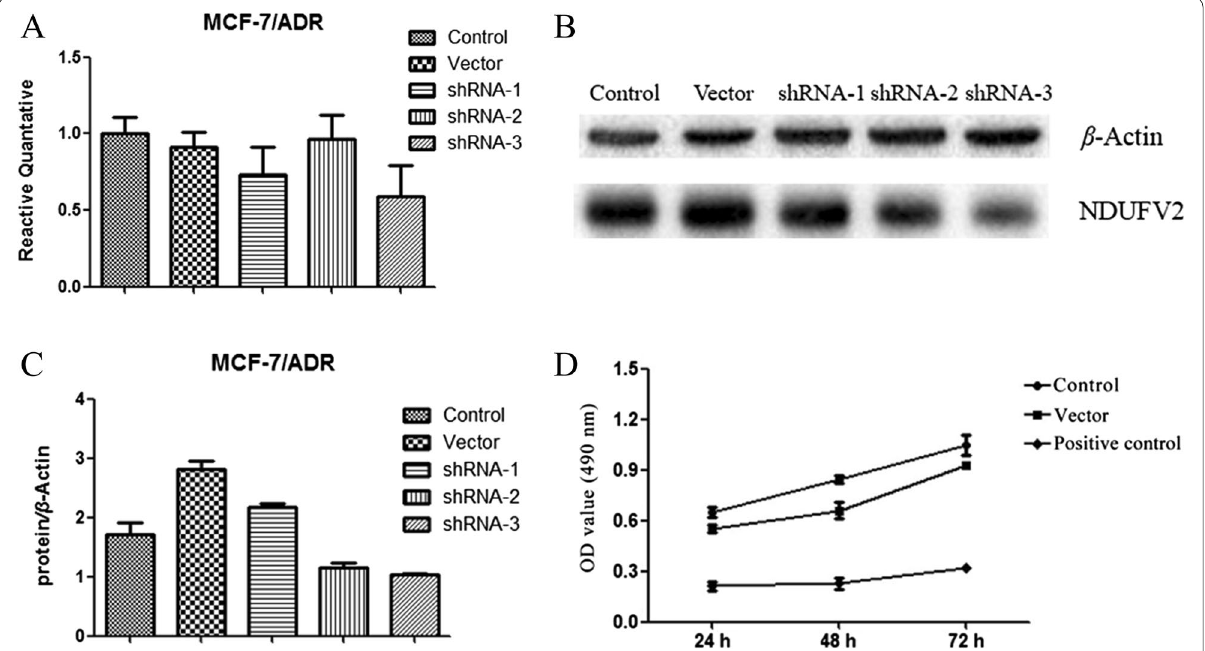
Fig. 2 Inhibition of NDUFV2 gene silencing on the proliferation of MCF-7/ADR cells. A The relative quantitative rates of NDUFV2 mRNAs in each group of MCF-7/ADR after transfection at different time points x ± s , n = 3 . B The protein expressions of NDUFV2 after transfection in MCF-7/ADR cells. β-actin was used as an internal reference protein, and NDUFV2 was used as the target protein. C The protein expressions of NDUFV2 in MCF-7/ ADR after transfection x ± s , n = 3 , β-actin was used as an internal reference protein and NDUFV2 was used as the target protein. For A , B , and C , cells transfected with PPLK /GFP PURO-NDUFV2 shRNA-1, 2, and 3 were used as the positive control (shRNA-1, 2, and 3), and cells transfected with + empty plasmid were used as negative control (vector), and the blank control group did not do any treatment (control). D The growth curves of each group of MCF-7/ADR after transfection at different time points x ± s , n = 3